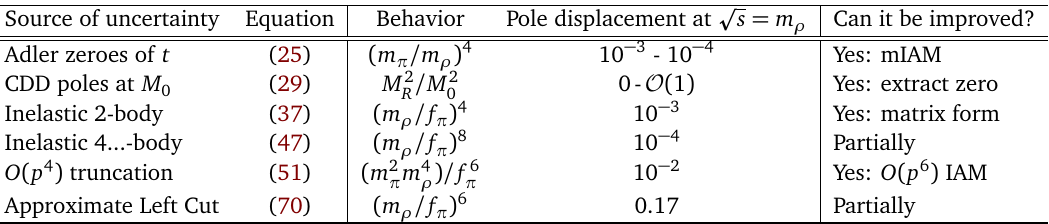
Table 3: Different sources of uncertainty for the Inverse Amplitude Method in Hadron Physics, their scaling if relevant, the order of magnitude of the error they introduce in the resonance region and whether the basic method can be improved to remove that source of uncertainty if need